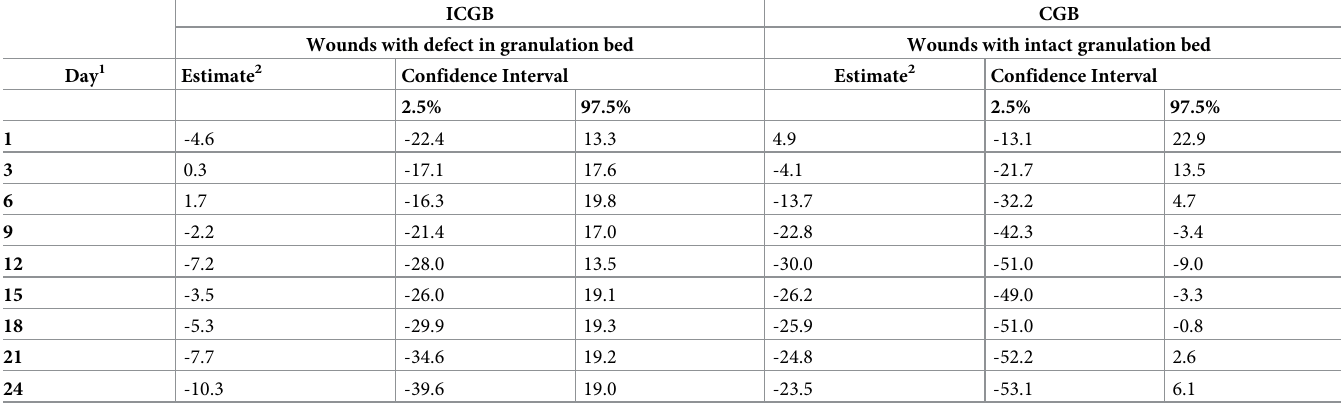
Table 2. Estimates and 95% confidence intervals of the difference between the mean % of wound area of probiotic treated and saline treated wounds of ICGB and CGB respectively in course of time. ICGB